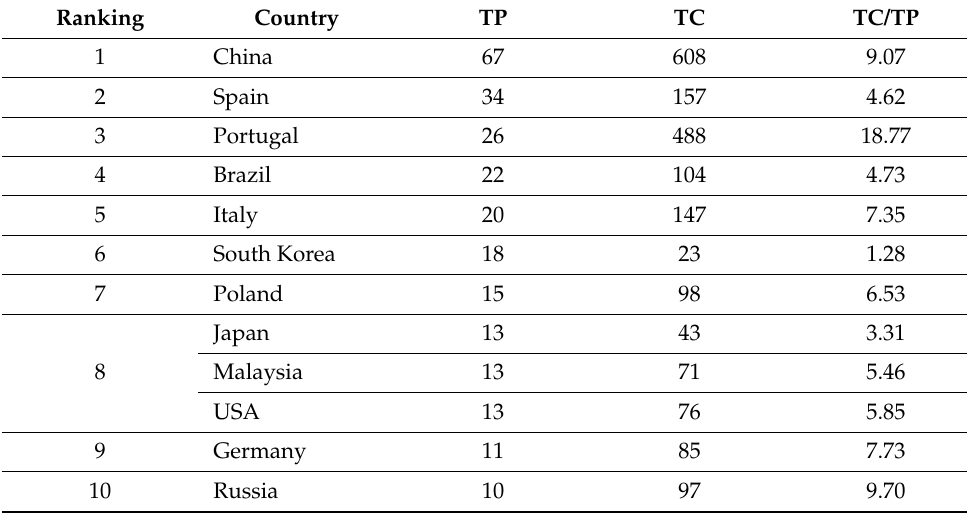
Table 4. Top 10 countries per number of publications.